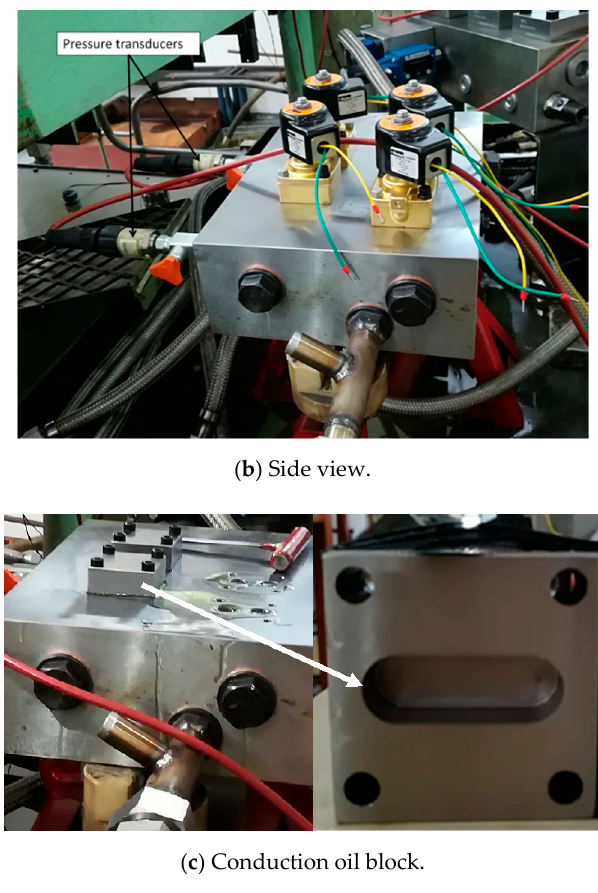
Figure 6. Test rig: ( a ) Front view; ( b ) Side view; ( c ) Conduction oil block.